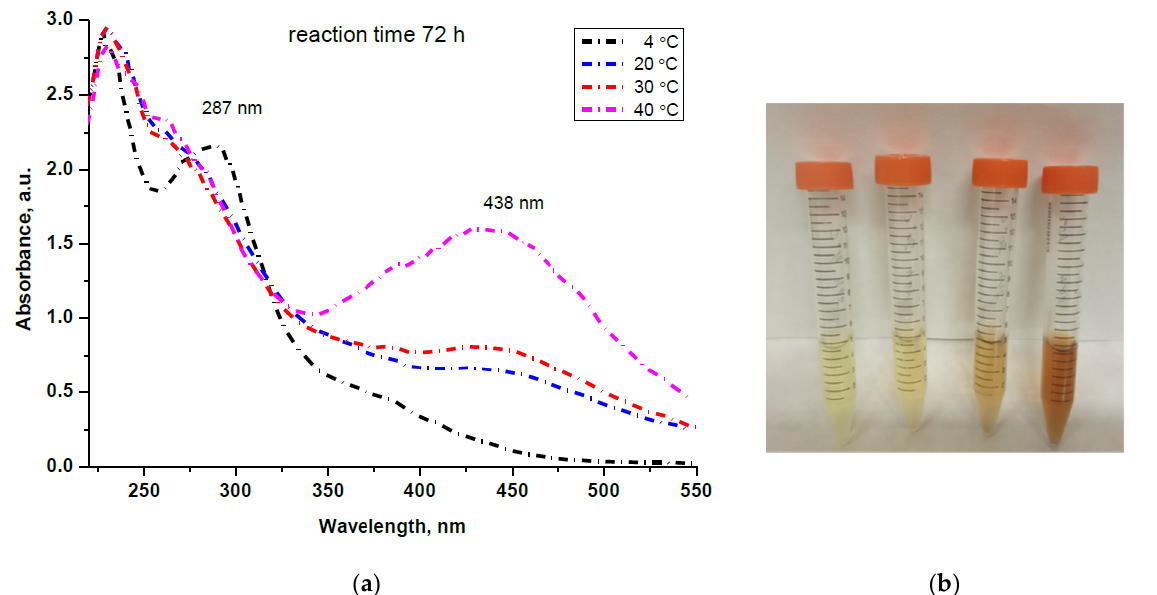
Figure 1. ( a ) UV–Vis spectra taken at 72nd h from the reaction mixtures kept at different temperatures (4, 20, 30 and 40 ° C). ( b ) Color change of the reaction mixture for 24 h at 4, 20, 30 and 40 ° C from left to right.